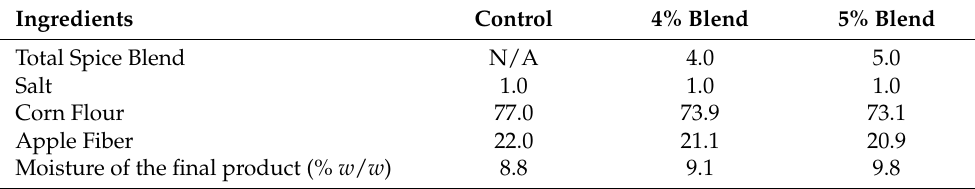
Table 1. Composition of the extruded snack * (g/100 g of product on dry-weight